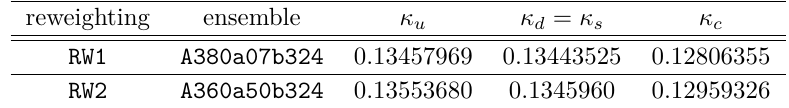
Table 3 . For each mass reweighting factor: the ensemble on which it is calculated and the target values of the hopping parameters.